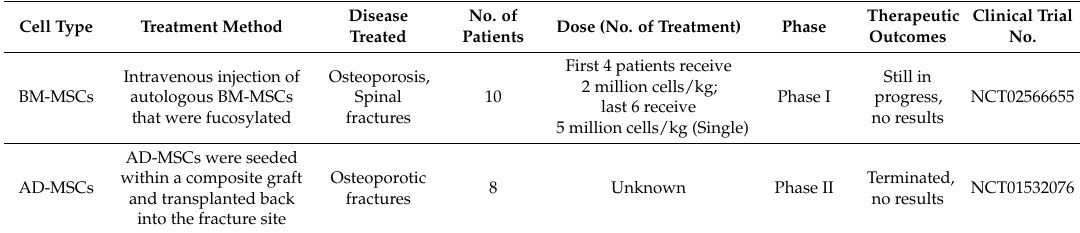
Table 2. Clinical trials with BM-MSCs and AD-MSCs in osteoporosis treatment. Cell